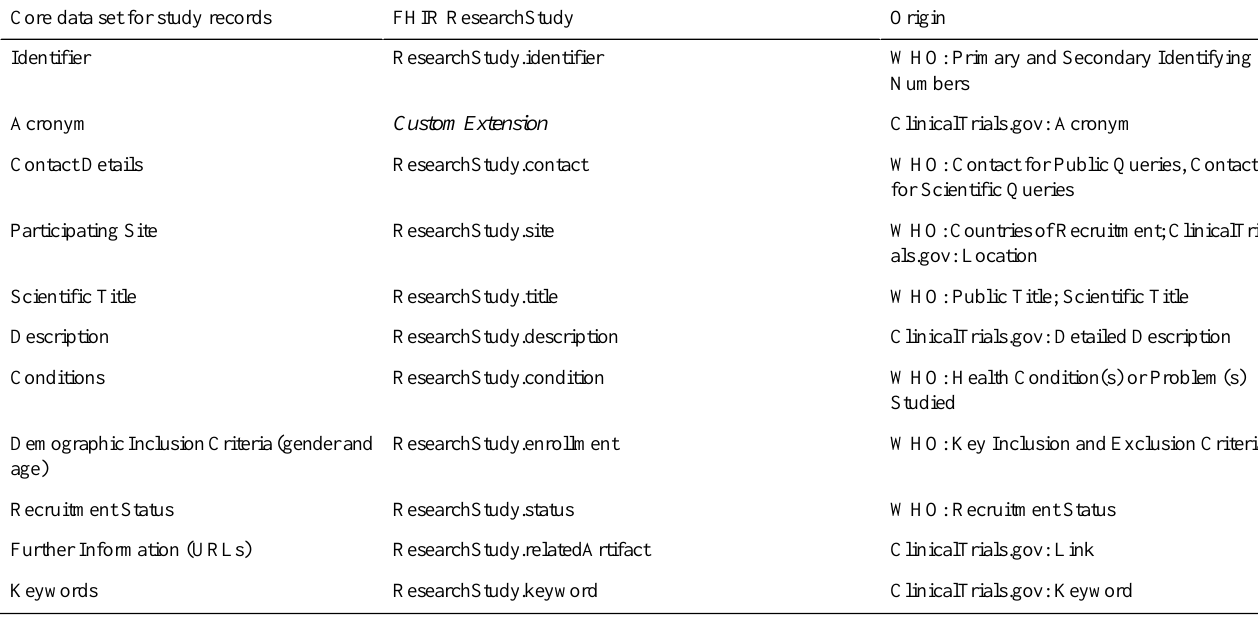
Table 1. Mapping between the defined data elements (including their origins) and Fast Healthcare Interoperability Resources (FHIR) ResearchStudy resources. WHO: World Health